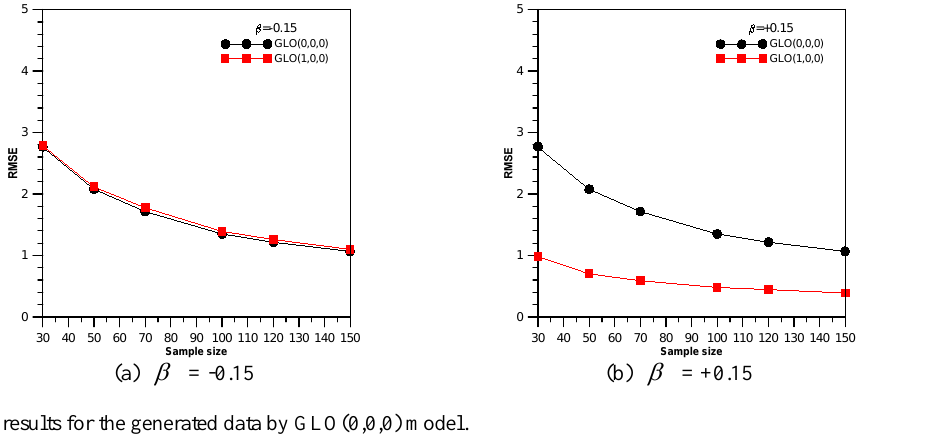
Figure 1. Simulation results for the generated data by GLO(0,0,0) model.